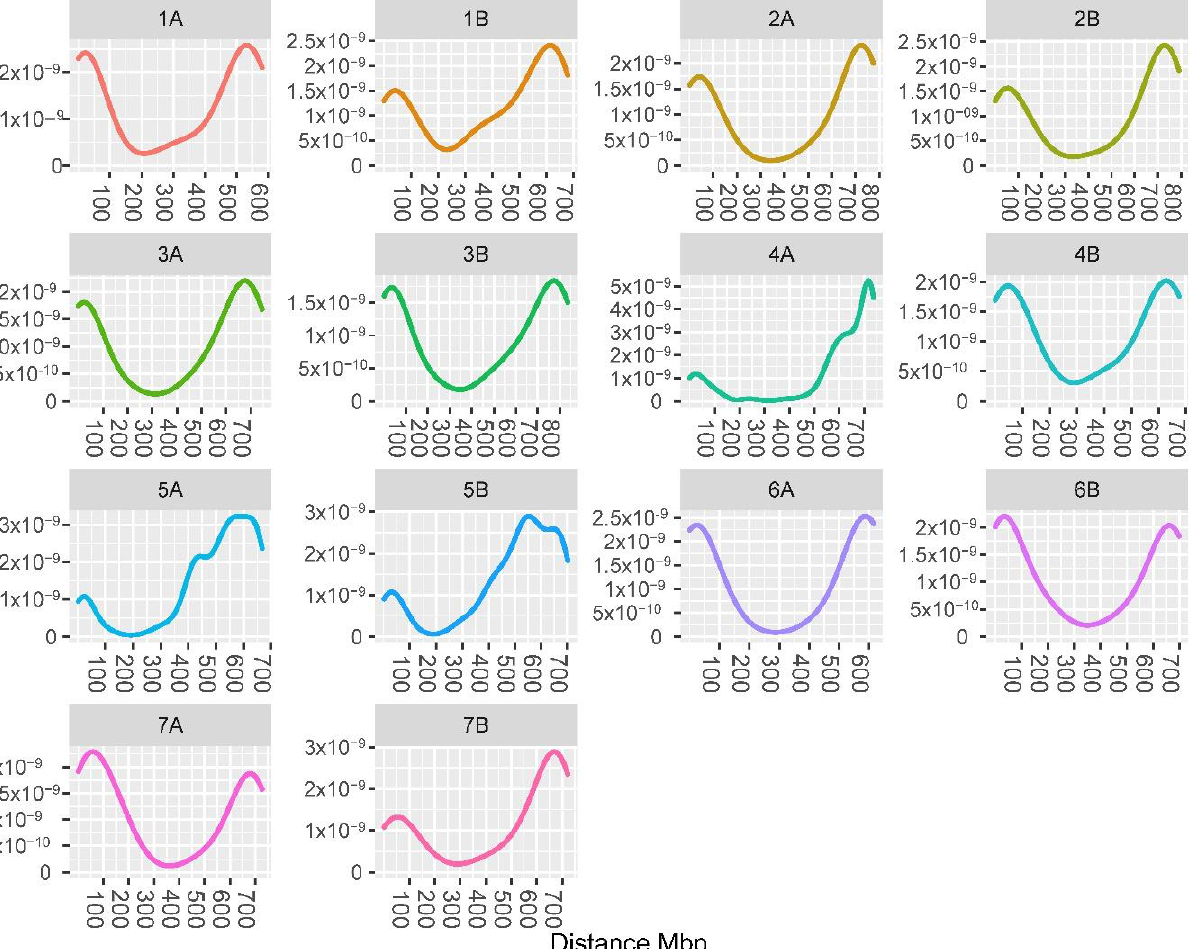
Figure 1. Marker distribution along ‘Svevo’